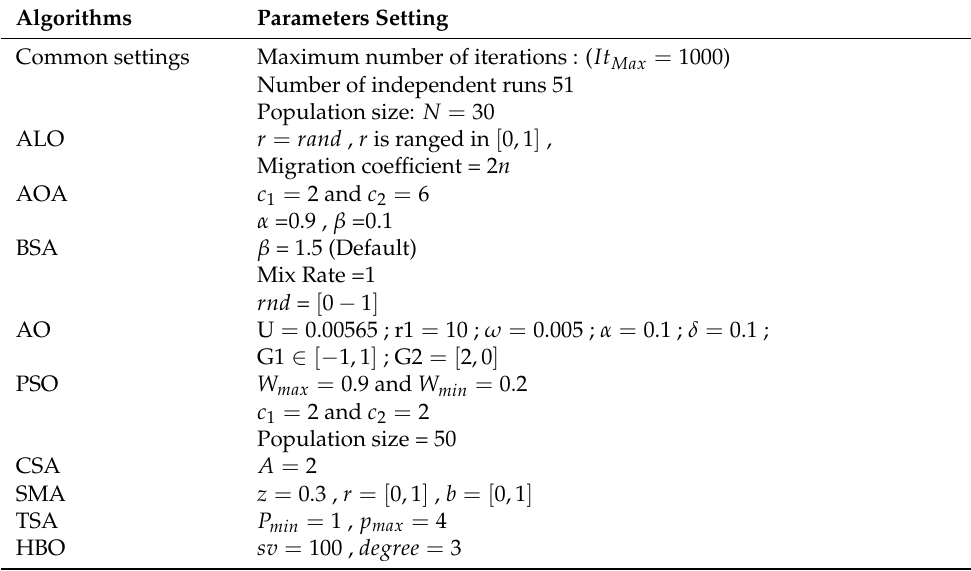
Table 3. Parameters settings of B_HBO and other computational